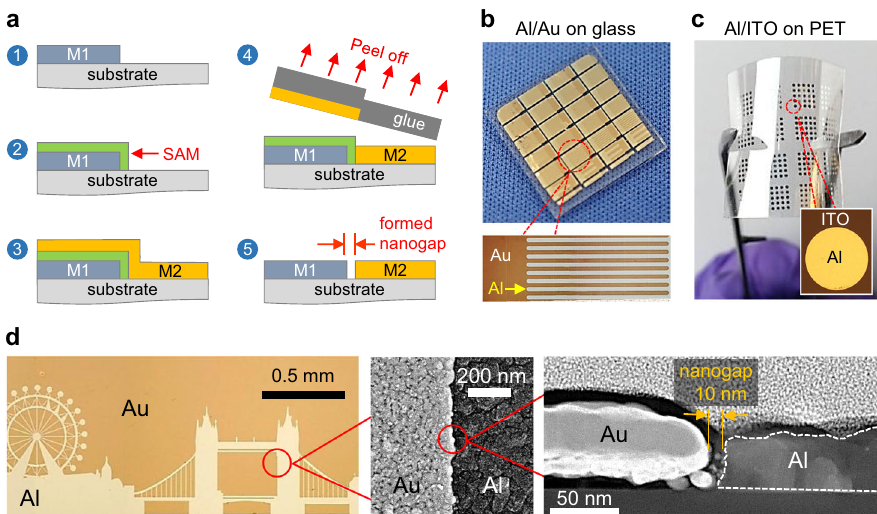
Fig. 1 Development of metal nanogaps via Adhesion lithography. a Adhesion lithography (a-Lith) process steps: ( 1 ) deposition and patterning of the fi rst metal (M1) on the substrate; ( 2 ) application of the self-assembled monolayer (SAM); ( 3 ) deposition of the second metal (M2); ( 4 ) application of adhesive material and peel-off; and ( 5 ) resulting nanogap after SAM removal by oxygen plasma. b Low and high-magni fi cation images of coplanar interdigitated Al/Au nanogap electrodes fabricated on glass. c Arrays of circular Al/ITO nanogap electrodes fabricated on a PET substrate. d Optical micrograph of a London skyline design accompanied by high-resolution (HR) plan-view SEM and cross-section HR- TEM images revealing the presence of a ≈ 10 nm size